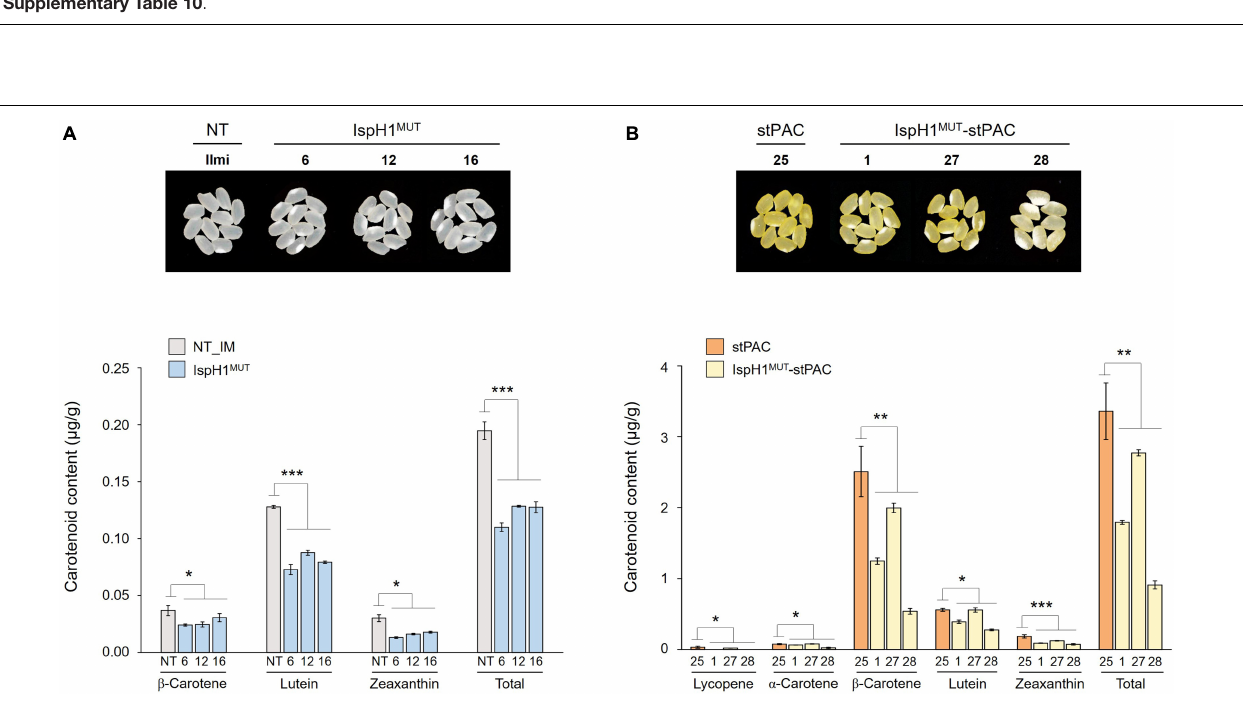
Frontiers in Plant Science |